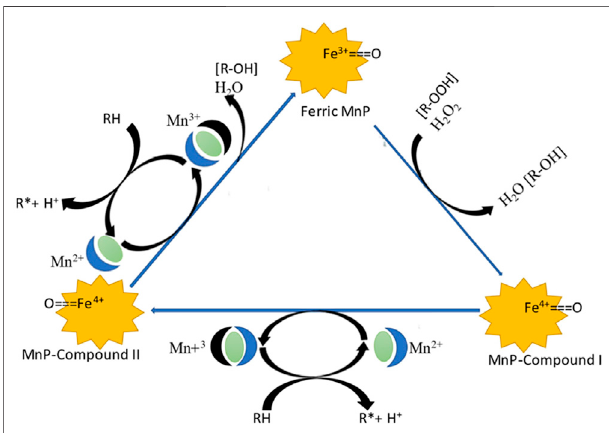
FIGURE 2 | Catalytic cycle of MnP (Hofrichter,